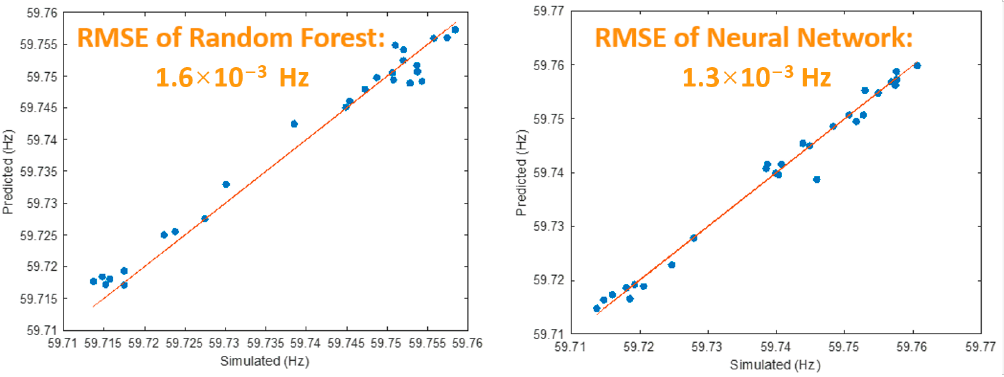
Figure 11. Error quantification of the AI-based frequency stability prediction.